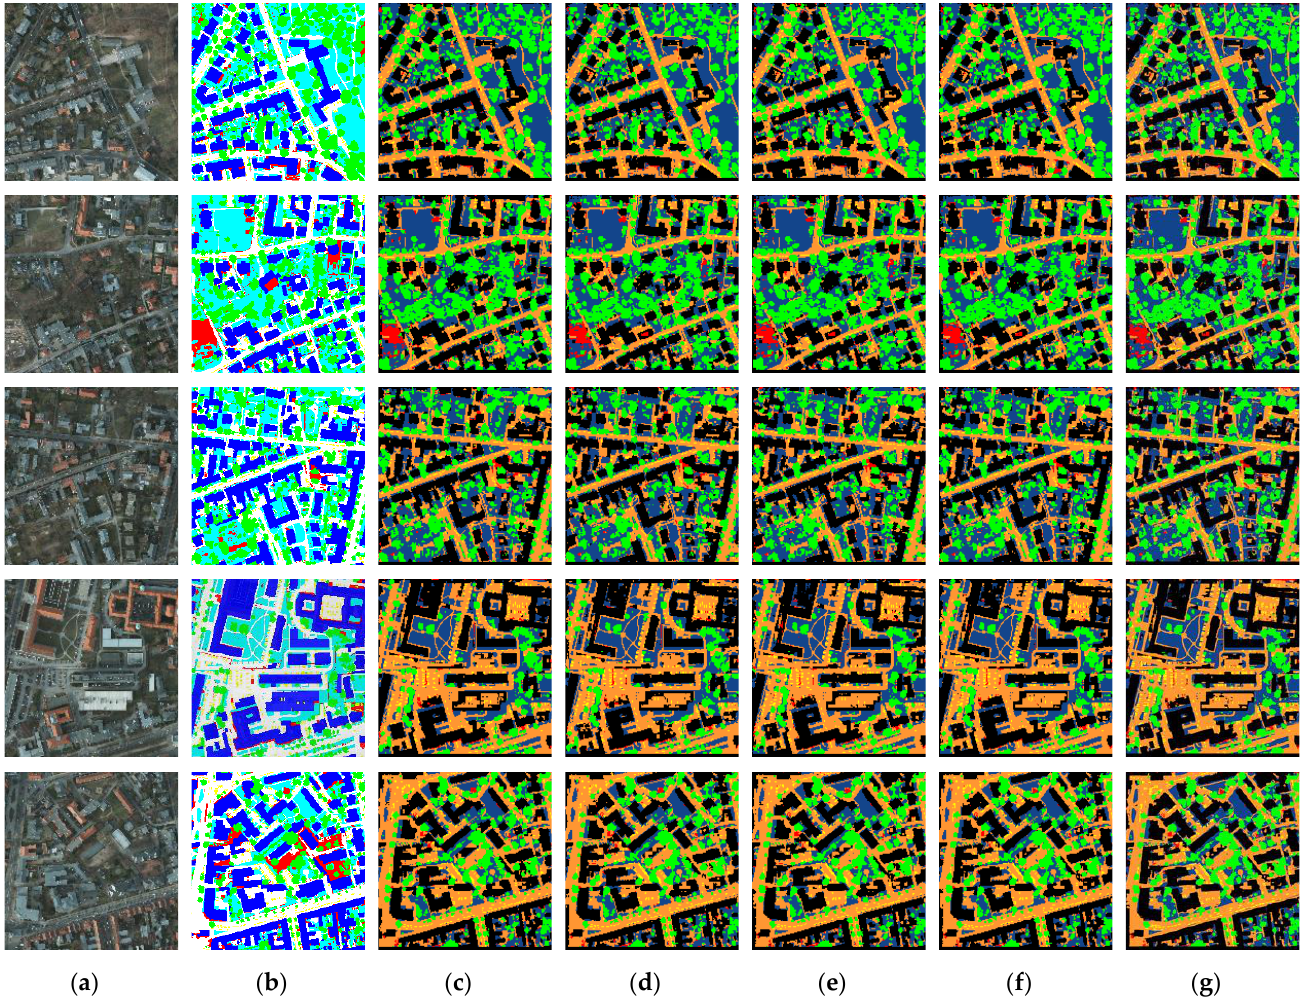
Figure 16. Examples of full-size output results of different models on the ISPRS Potsdam dataset: ( a ) original image, ( b ) ground truth, ( c ) SegNet, ( d ) U-Net, ( e ) PSPNet, ( f ) Deeplabv3+, ( g ) LPASS-Net, where the category details are shown in Table 8. In addition, the visualization results of each model are obtained by adding EPCP to ensure the fairness of the ablation experiment. Table 8. Details of each category in the prediction results.